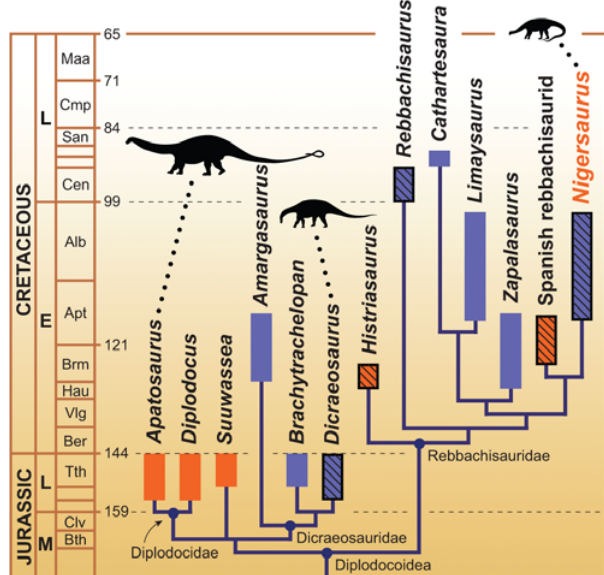
Figure 4. Calibrated phylogeny of diplodocoid sauropods. The diagram is based on strict consensus of five minimum-length trees using 13 ingroup taxa and 102 unordered characters (CI=0.76; RI=0.78) (Text S5). Scaled icons represent a diplodocid ( Apatosaurus ) [11], dicraeosaurid ( Dicraeosaurus ) [51], and a rebbachisaurid ( Nigersaurus ). Geographic distributions include Laurasian diplodocoids (western North